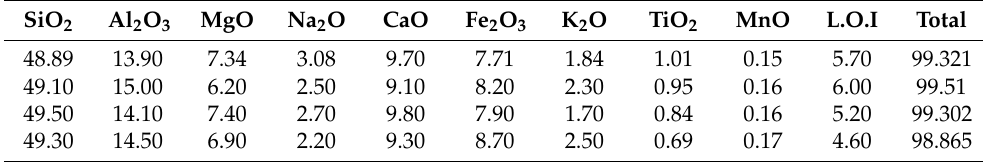
Table 3. Geochemical composition of pumice rock in (wt %).